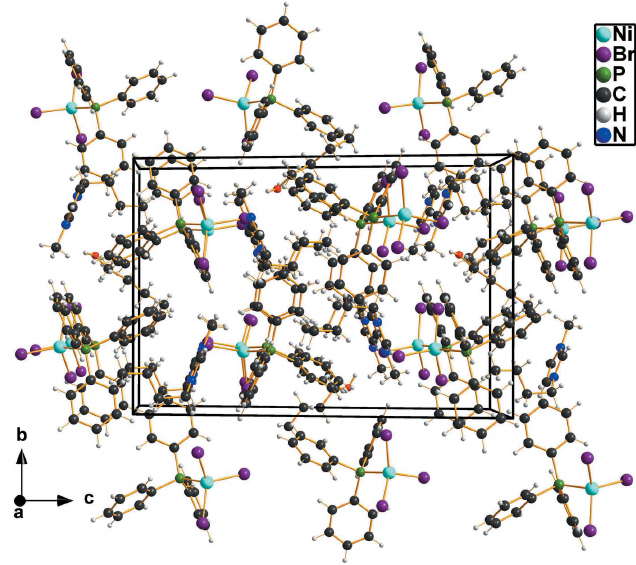
Figure 1 The structure of the molecular cation–anion pair in (BMIm)[- NiBr 3 (P(C 6 H 5 ) 3 )] (cid:2) 0.5(C 4 H 10 O). Displacement ellipsoids are drawn at the 50% probability level; the disordered co-crystallized 1-butanol molecule has been omitted for clarity.